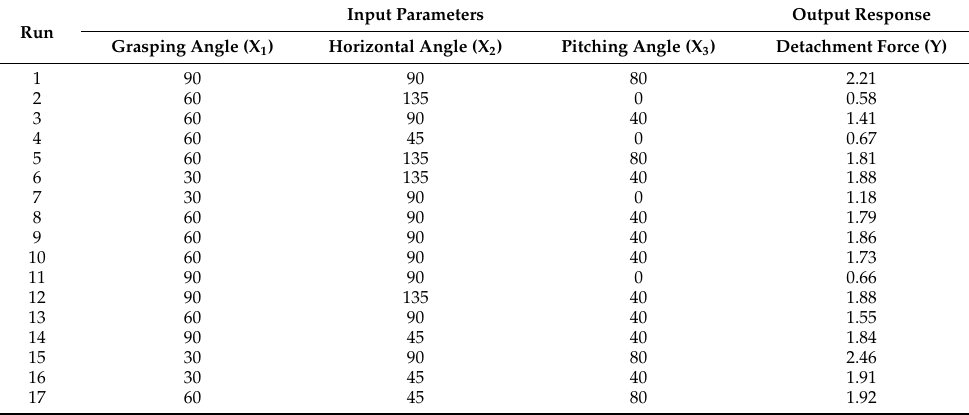
Table 3. Experimental design made up of three independent variables at three levels, and the simulation results of the responses.